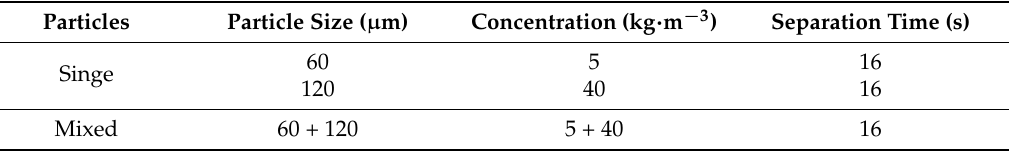
Table 5. Experiments for particle separation.